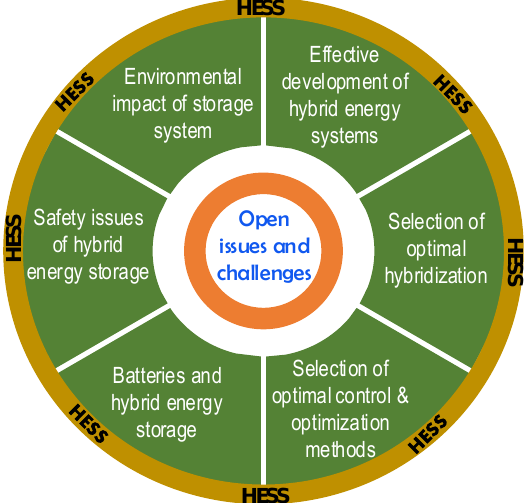
Figure 16. Main issues and challenges of HESS.